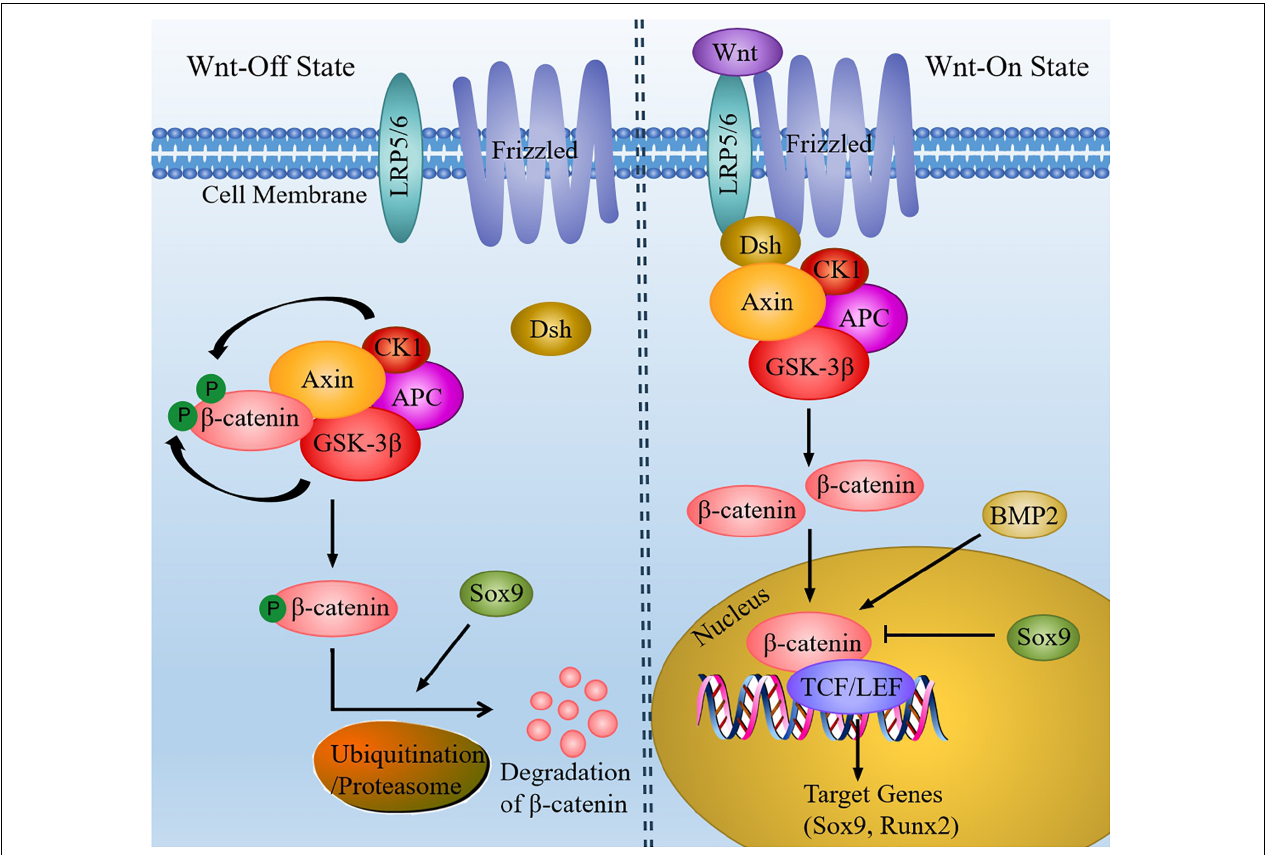
FIGURE 2 | The canonical Wnt signaling pathway in chondrocytes. In the absence of Wnt, β -catenin could be phosphorylated by CK1 and GSK-3 β . When Wnt signaling is activated, Wnt ligands combine with Frizzled and LRP5/6, and then recruit Dsh and destruction complex. So that the level of cytoplasmic β -catenin is increased. Subsequently, β -catenin enter the nucleus and bind to TCF/LEF to regulate the transcription of target genes (Sox9 and Runx2). In addition, BMP2 can increase the expression of nuclear β -catenin, whereas increased expression of Sox9 can inhibit β -catenin signaling and facilitate degradation of β